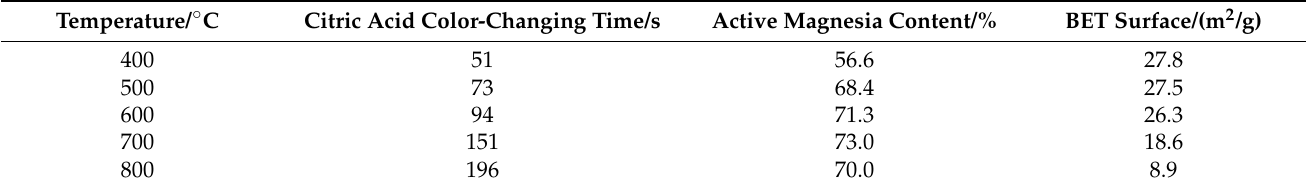
Table 4. Properties of magnesia obtained from the magnesium residue calcined at different temperature. Temperature/°C